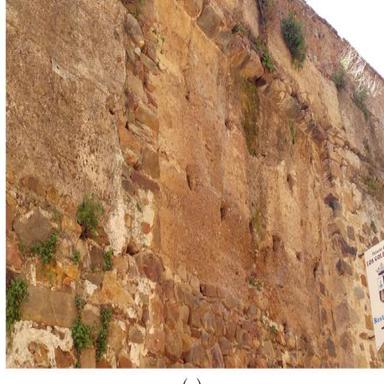
Detail of the walls where were extracted samples MC-14 (a), MC-13 (b), MC-11 (c), MC-16 (d) and MC-2 (e).